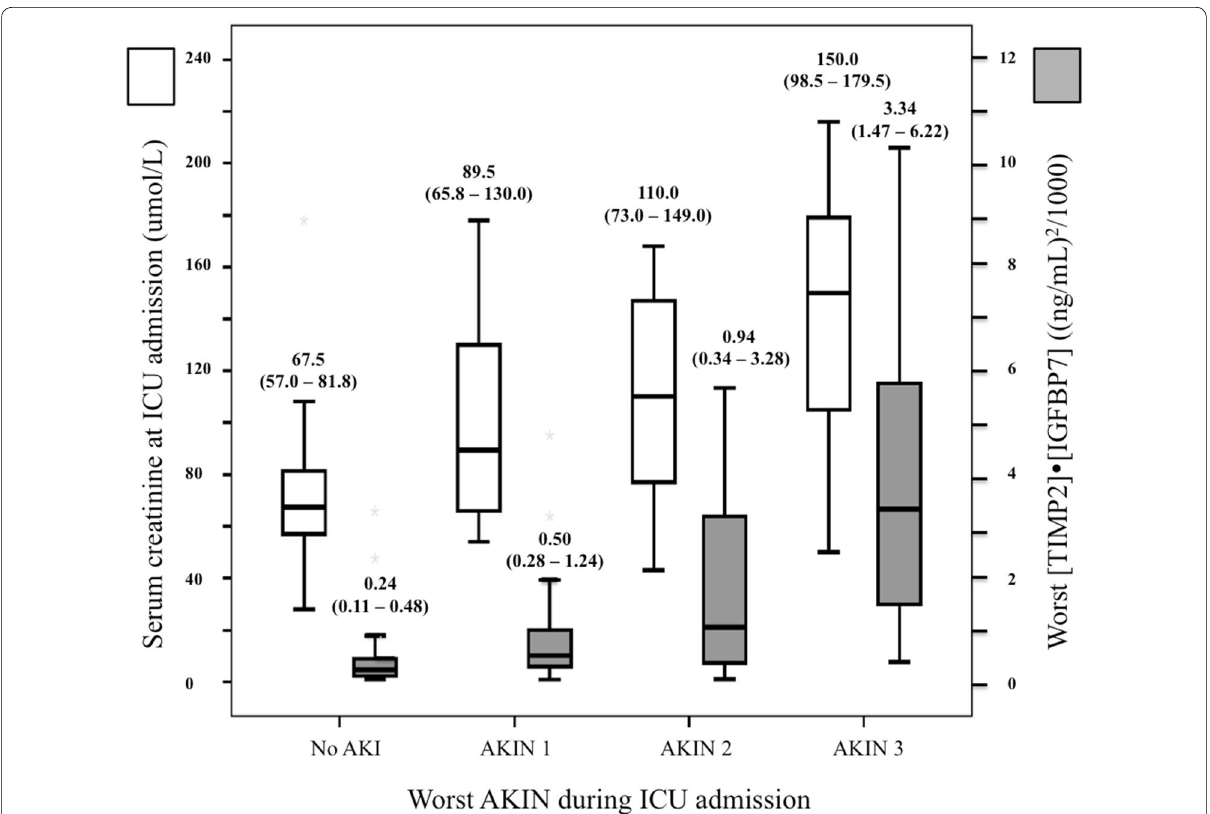
Fig. 2 Boxplot comparing the worst [TIMP‑2] [IGFBP7] index and sCr upon admittance with the worst AKIN. Boxplots indicate the median, 25th and · 75th percentiles. Whiskers indicate the 5th and 95th percentiles. Statistical significance ( p ) comparing each biomarker index with AKIN and RIFLE categories. p was determined by Kruskal–Wallis test, not correlation. We found statistical differences in the worst [TIMP‑2] [IGFBP7] index concentra‑ · tions when comparing the subgroup without AKI with any degree of AKI defined by AKIN. Between non‑AKI and AKIN 1, p was 0.014 and p < 0.001 when comparing with AKIN 2 and AKIN 3. In between AKIN 1 and AKIN 3, p 0.004, whereas in between AKIN 2 and AKIN 3 p 0.039. When = = comparing sCr levels with AKIN, we found differences between the subgroup without AKI with AKIN 1 ( p 0.008), AKIN 2 and 3 (for both p < 0.001). = In between AKIN 1 and 3, p was 0.048 and